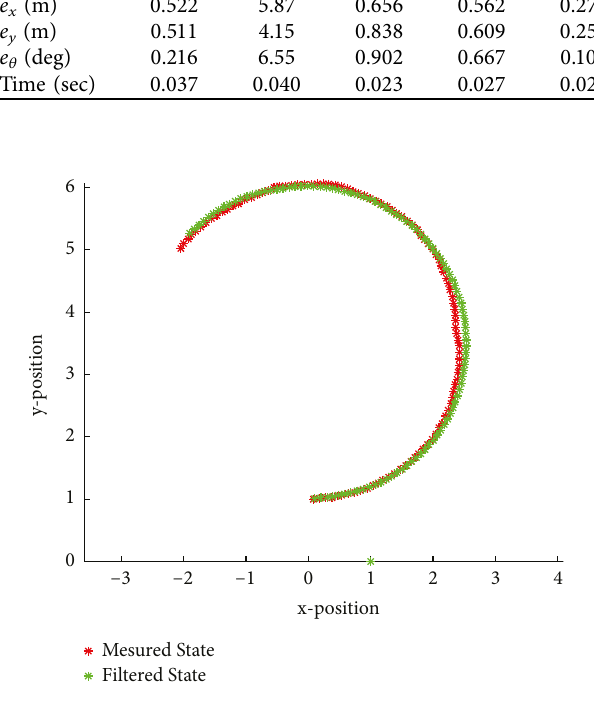
Figure 11: The state of the WMR using the PF with one landmark and Gaussian noise.